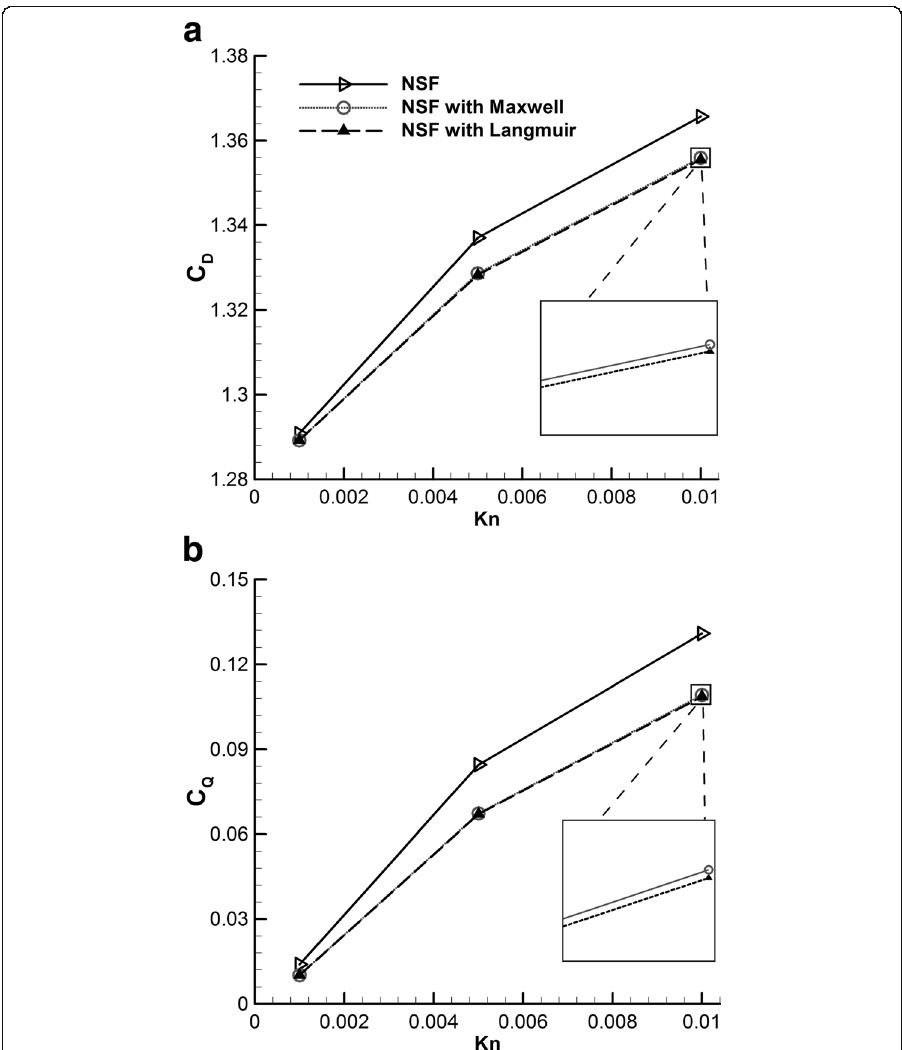
Fig. 17 Comparison of the aerothermodynamic coefficients for varying Knudsen numbers (0.001, 0.005, and 0.01) at M = 6: a drag coefficient, and b heat flux